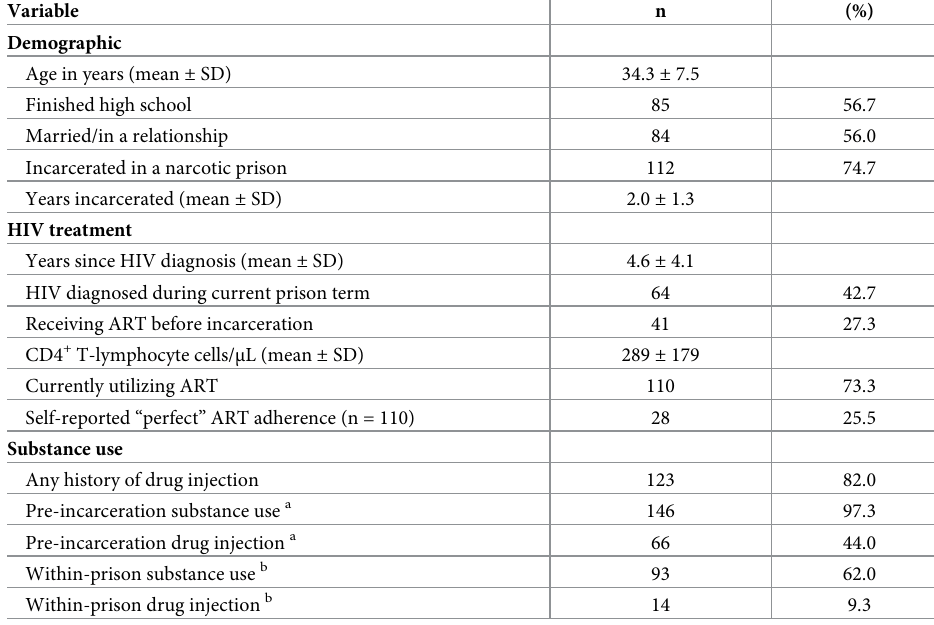
Table 1. Characteristics of HIV-infected males in prison (n =